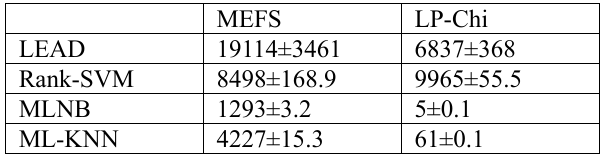
Table 8. Comparison of computing